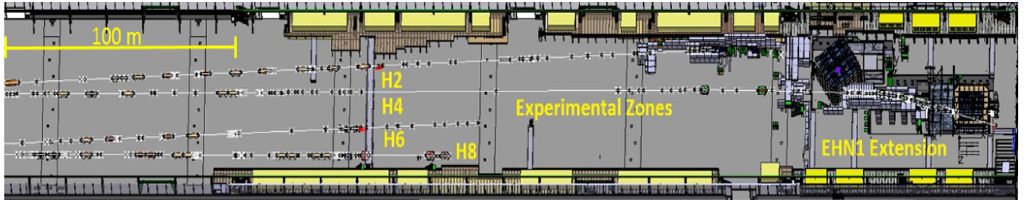
FIG. 1. 3D drawing of the EHN1 hall. On the left the upstream part of the four beam lines (H2, H4, H6 and H8) in the hall can be seen. The new extension part for the hall is shown on the right part.